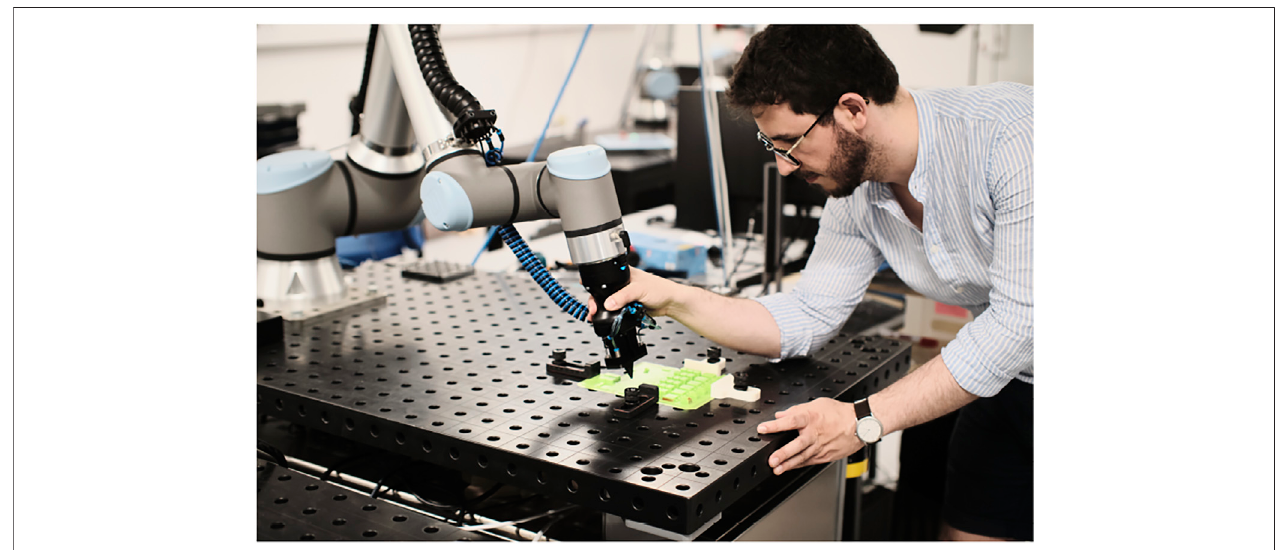
FIGURE 1 | User demonstration of a gluing-like task on our benchmark